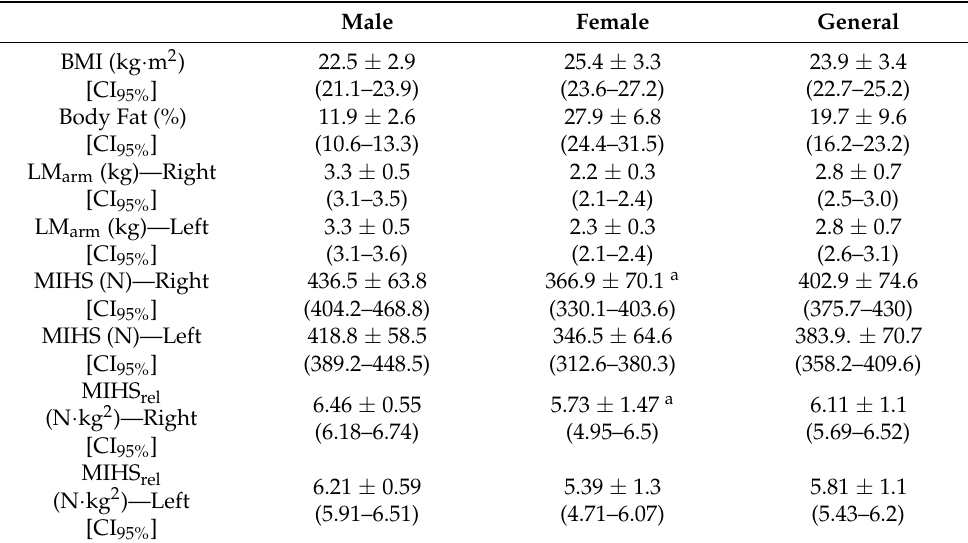
Table 1. Body composition and isometric handgrip strength.